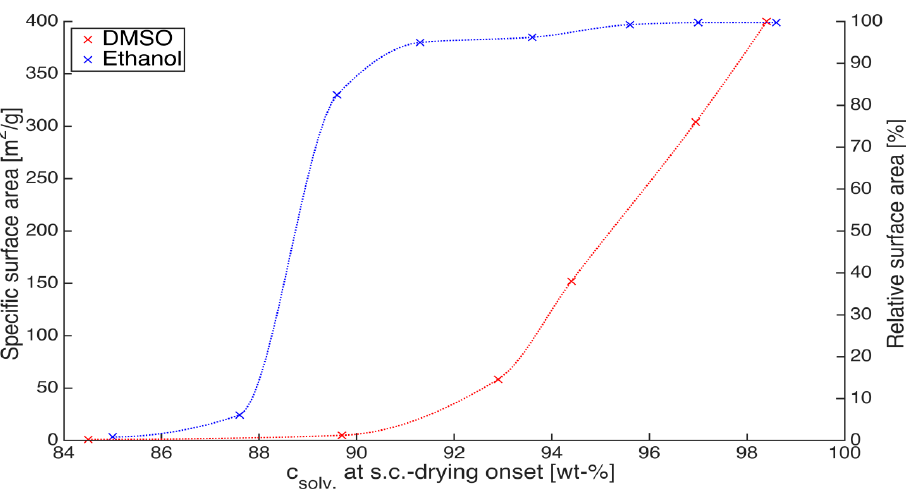
Figure 7. Surface area as a function of solvent concentration achieved before supercritical CO 2 drying onset; gel composition: 1 wt % calcium alginate,